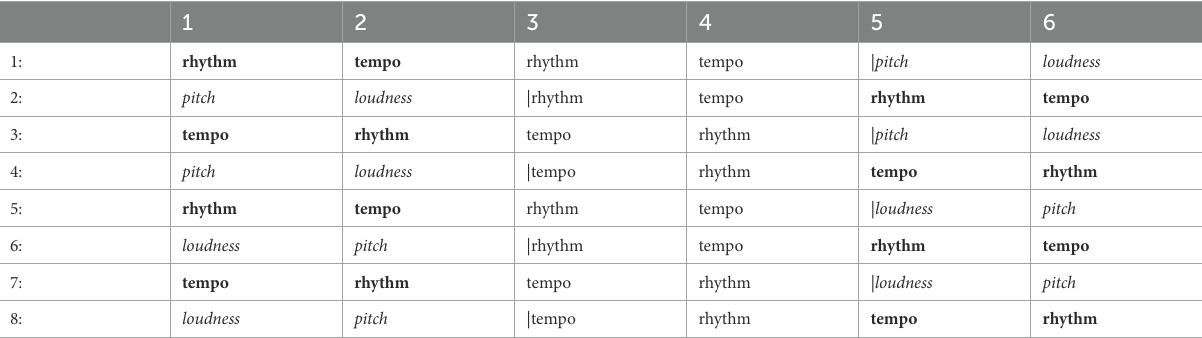
TABLE 1 Sequences of administration of the tasks: reproduction tasks (bold); perception tasks—temporal (standard); and perception tasks—non- temporal (italicized). 1